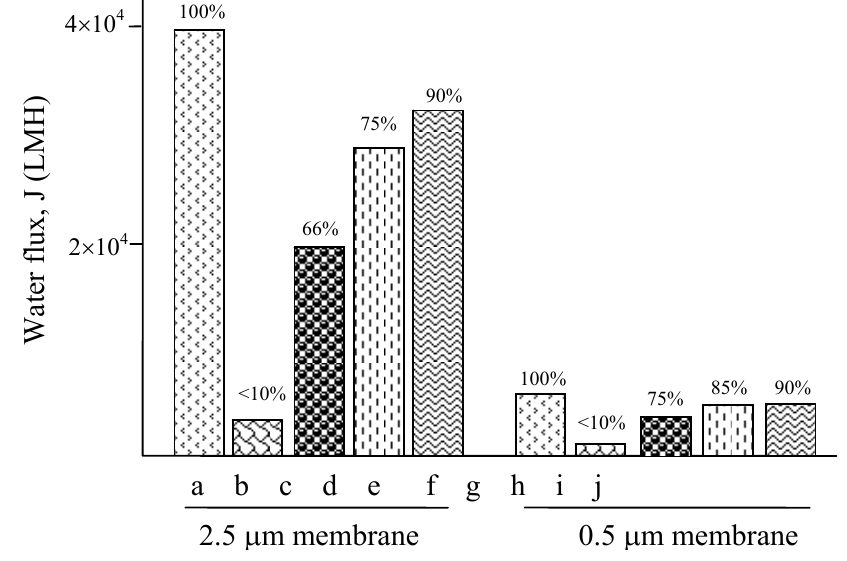
Figure 9. Comparison of the water flux restore after cleaning with different methods. (a) Original; (b) Fouled; (c) Back flush with 100 L water at 50 kPa; (d) Plus electric field at 50 V; (e) Plus 0.2% nitric acid wash for 10 min; (f) Original; (g) Fouled; (h) Back flush with 100 L water at 100 kPa pressure; (i) Plus electric field at 50 V; (j) Plus 0.2% Nitric acid wash for 10